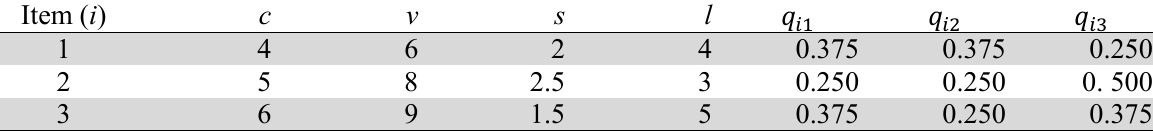
The parameter values of the multi-item newsvendor